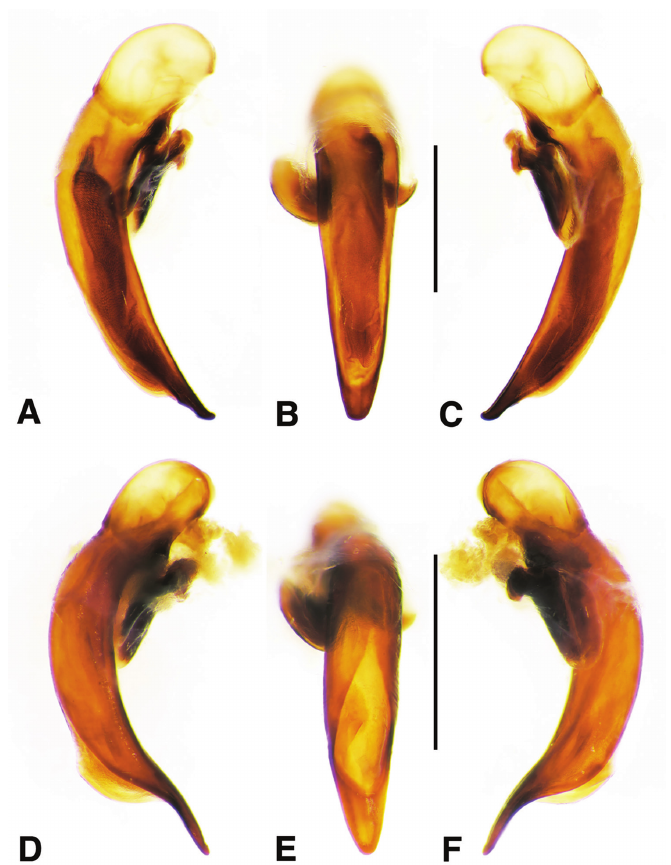
Figure 42. Digital images of male genitalia of Selenophorus opalinus species group, in part. A, D right lateral aspect B, E dorsal aspect C, F left lateral aspect. A–C S fabricii sp. n. D–F S. flavilabris ubancus Ball & Shpeley. Scale bars 1